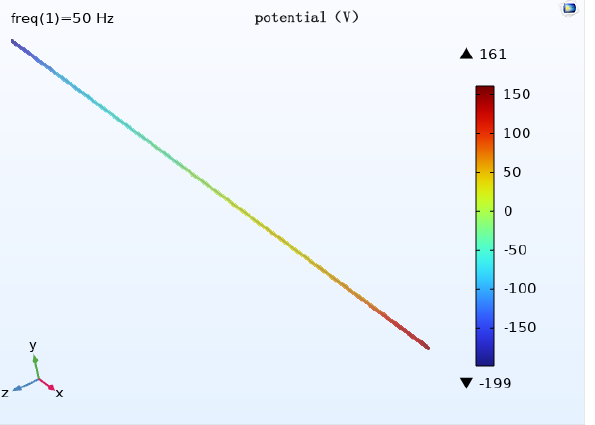
Figure 18. Transmission line to a ground height of 28 m when the pipeline cathodic protection potential is distributed.